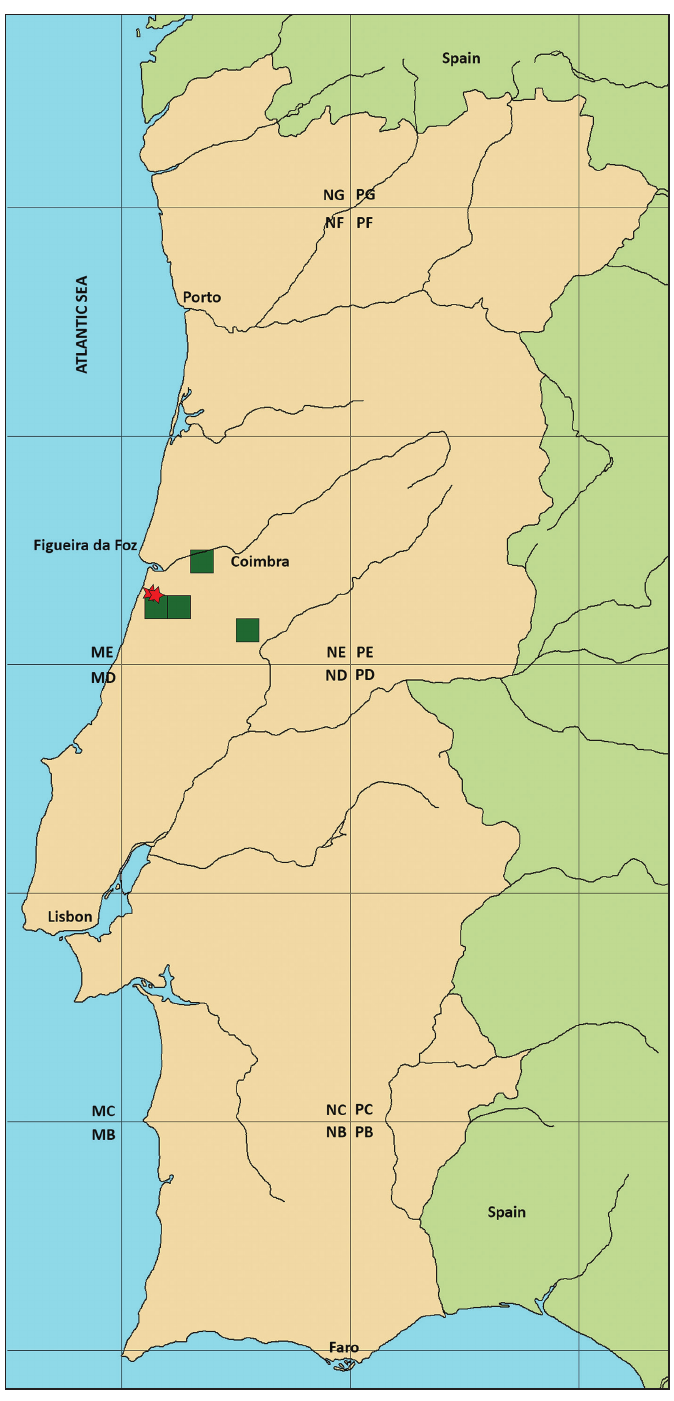
Figure 1. Distribution of B. crimnodes in Portugal (green squares). Red stars indicate the location of paper